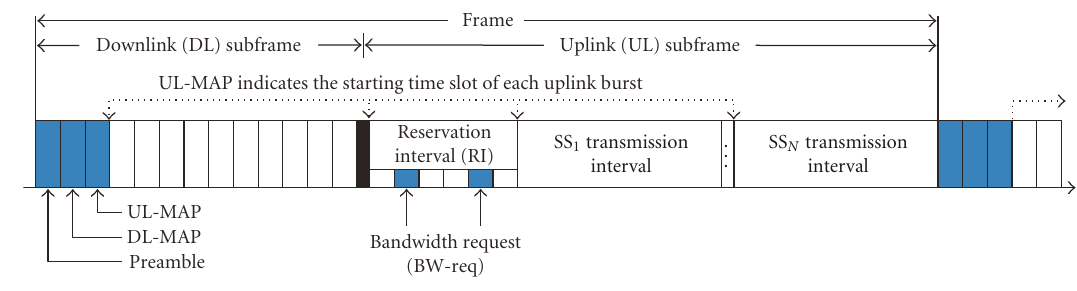
Figure 2: IEEE 802.16 MAC frame structure in TDD/TDMA